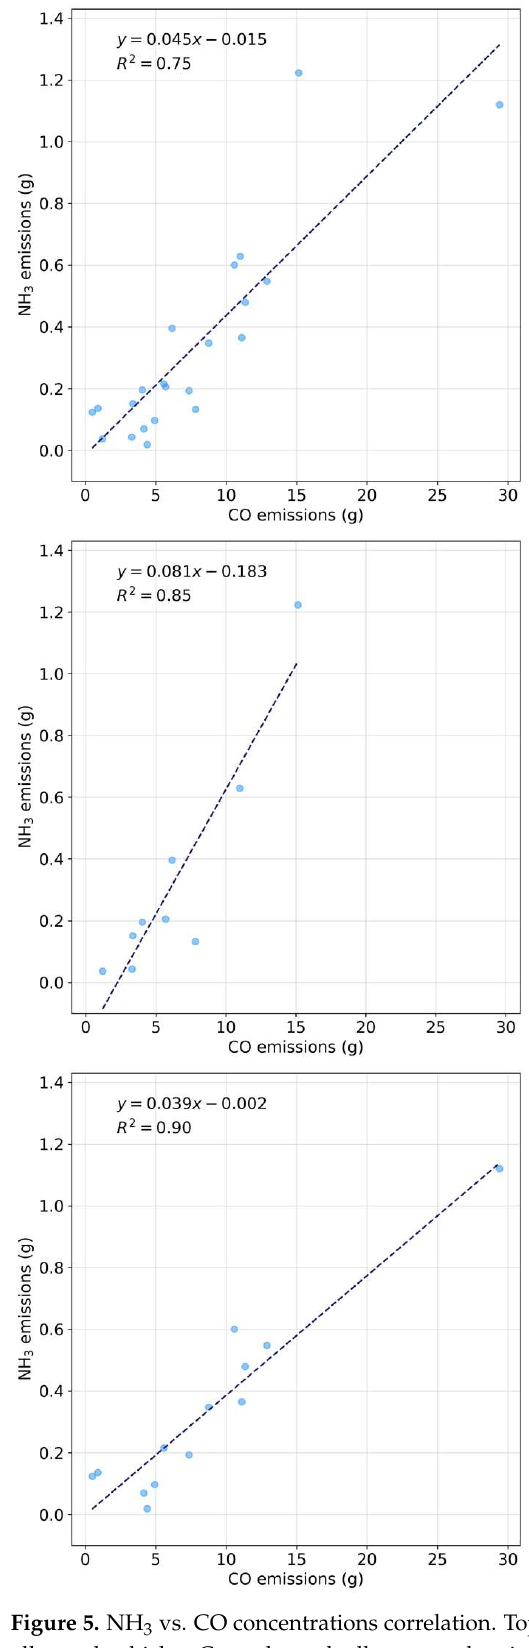
Figure 5. NH 3 vs. CO concentrations correlation. Top panel: all measured emissions per vehicle for all tested vehicles. Central panel: all measured emissions from pure ICE vehicles. Bottom panel: all measured emissions from hybrids and